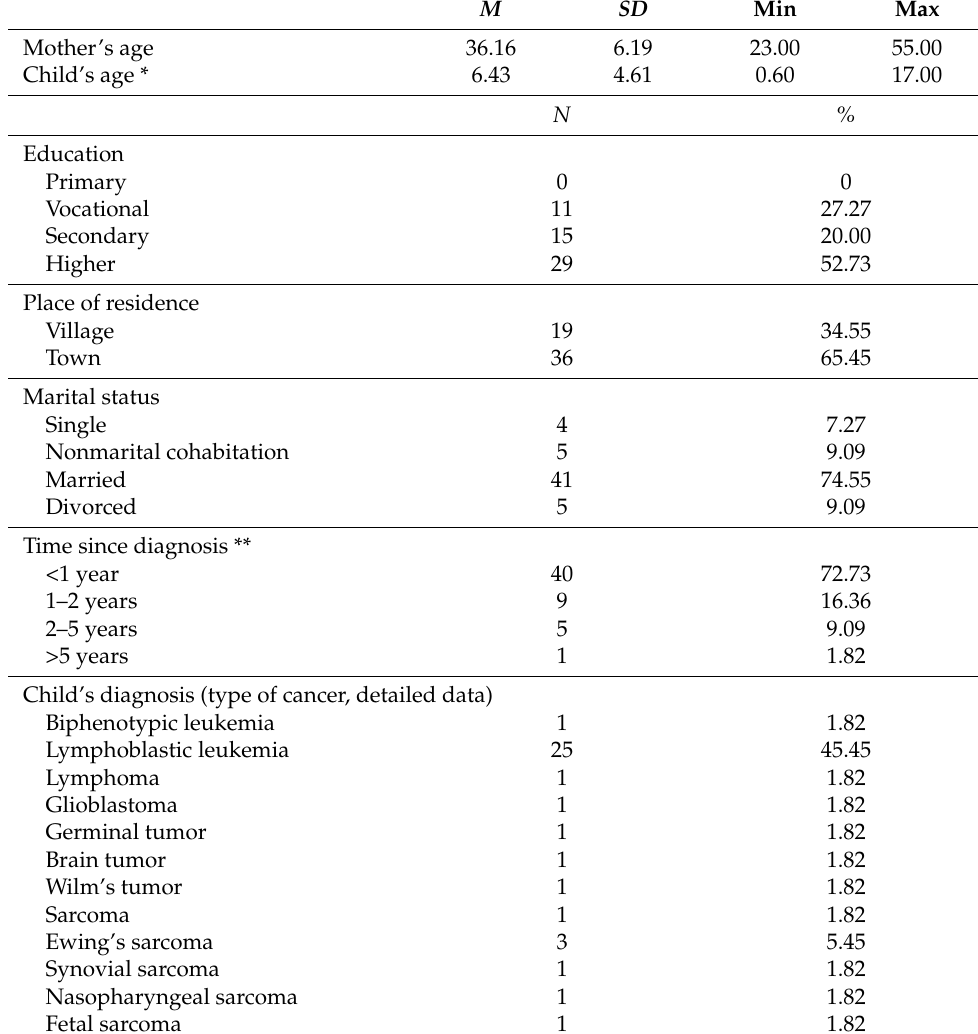
Table 1. Characteristics of the sample ( n = 55